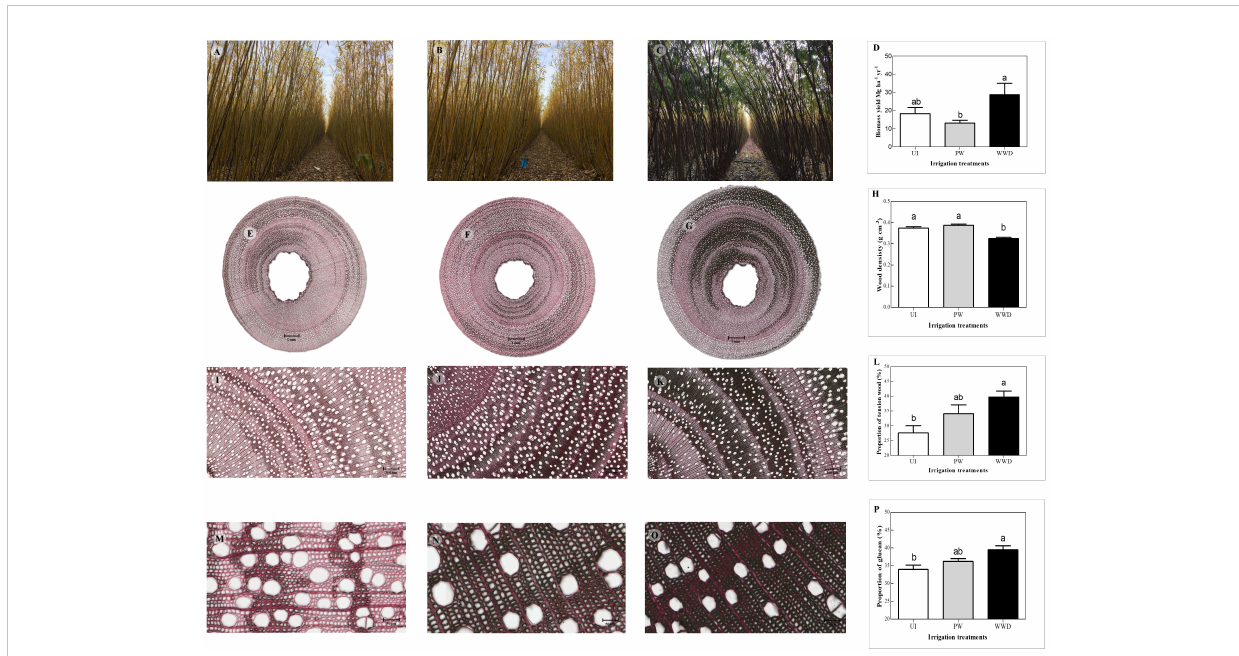
FIGURE 1 Effects of nitrogen fertilization with primary municipal wastewater on the biomass, mechanical structure and willow wood composition. A – C ) Trees with irrigation treatments UI, PW and WWD respectively. (E – G) Stem section from trees with irrigation treatments UI, PW and WWD respectively (scale bar = 1mm). (I – K) 100x magni fi cation of stem section region from trees with irrigation treatments UI, PW and WWD respectively (scale bar = 200 µm). (M – O) 500x magni fi cation of stem section region from trees with irrigation treatments UI, PW and WWD respectively (scale bar = 50 µm). (D) Above ground biomass (Mg ha -1 ) of irrigation treatments UI, PW and WWD respectively (previously published results in Jerbi et al. (2020)). (H) Wood density (g cm -3 ) of treatments UI, PW and WWD respectively. (L) Proportion of tension wood (%) of irrigation treatments UI, PW and WWD respectively. (P) Wood proportion of glucan (%) of treatments UI, PW and WWD respectively. The results represent the average values (mean ± standard error) for each irrigation treatment. Different letters indicate signi fi cant differences according to HSD-Tukey test for the irrigation treatments (p ≤